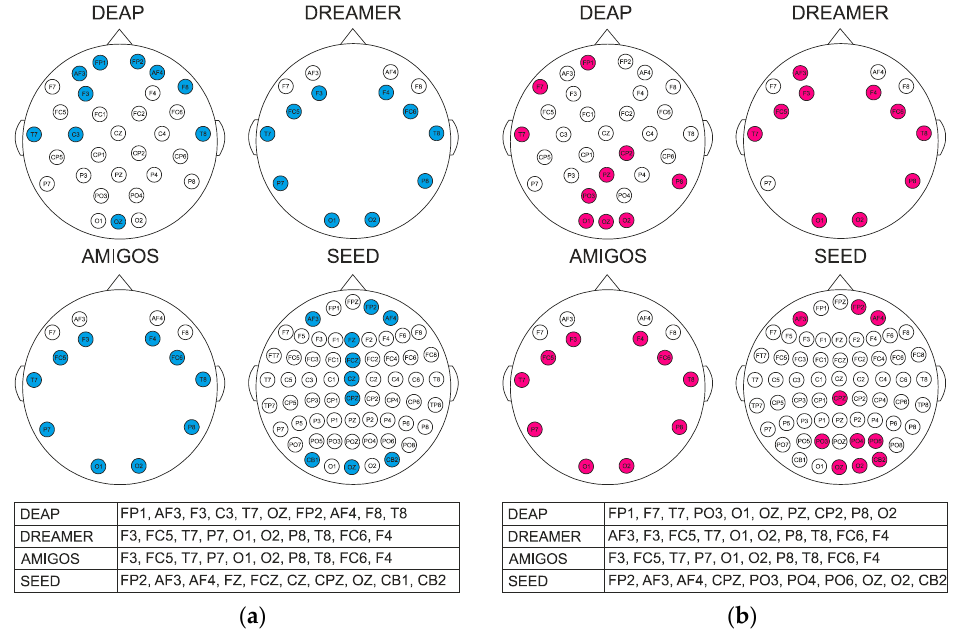
Figure 6. Head map with top 10 channels selected with ReliefF on ( a ) male (highlighted in blue) and ( b ) female (highlighted in red) participants for each dataset.